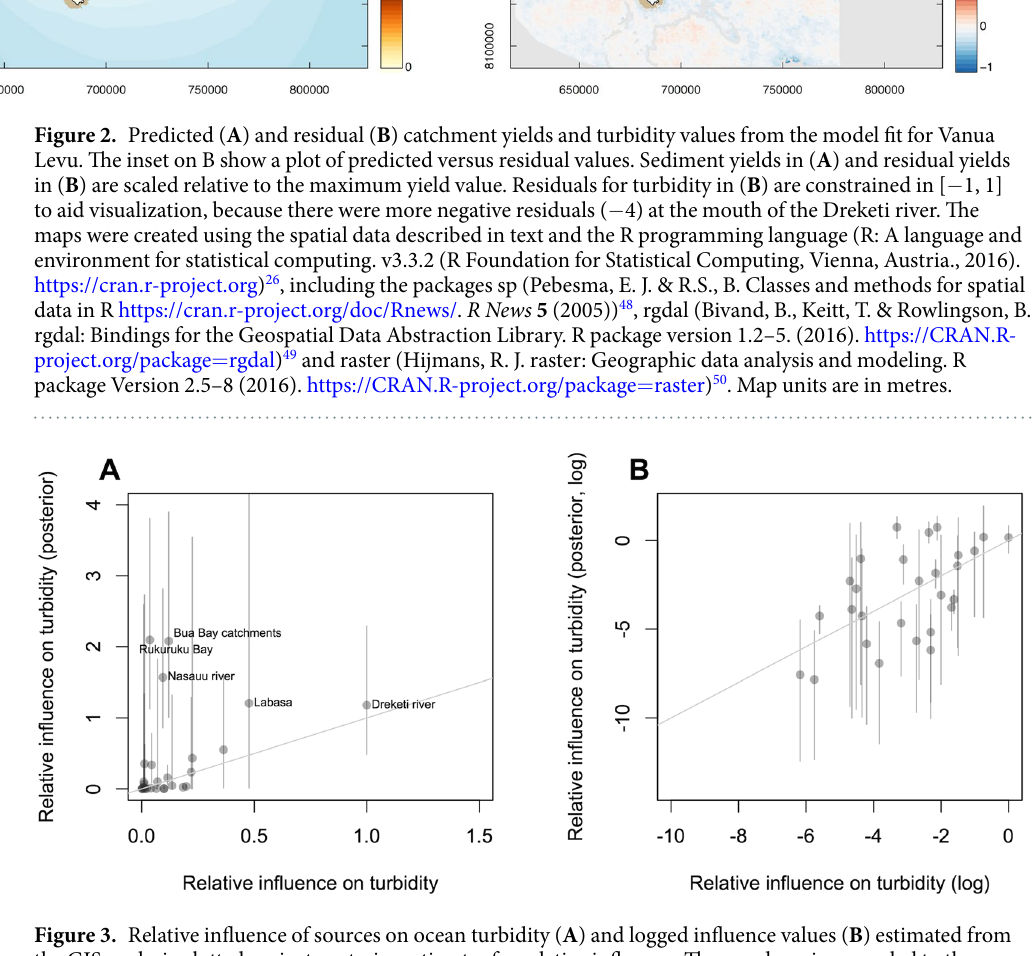
Figure 3. Relative influence of sources on ocean turbidity ( A ) and logged influence values ( B ) estimated from the GIS analysis plotted against posterior estimates for relative influence. The x and y axis are scaled to the same units by dividing the x-axis by the slope from the mean estimate of the yield-influence parameter ( θ ). Error bars show 95% credibility